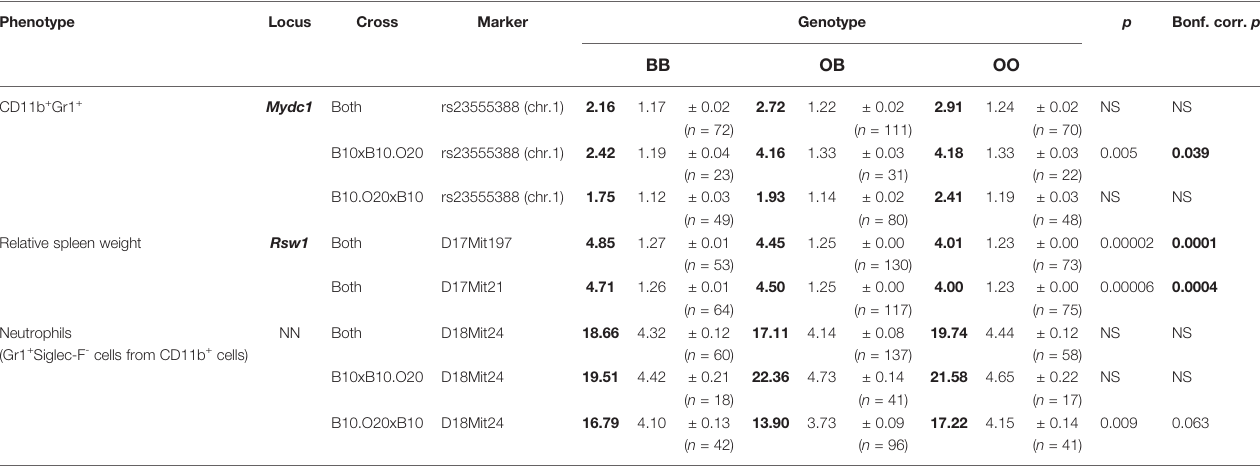
TABLE 3 | Loci controlling frequencies of myeloid-derived spleen cells and relative spleen weight in F 2 hybrids between B10.O20 and